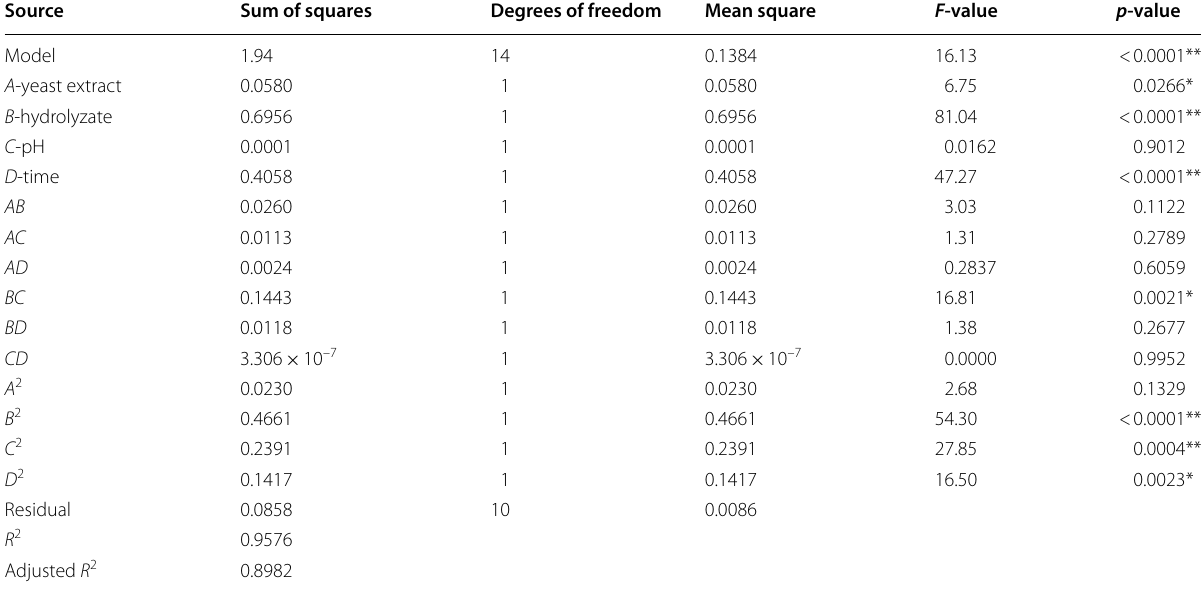
Table 3 ANOVA for response surface quadratic model for biomass production by B.